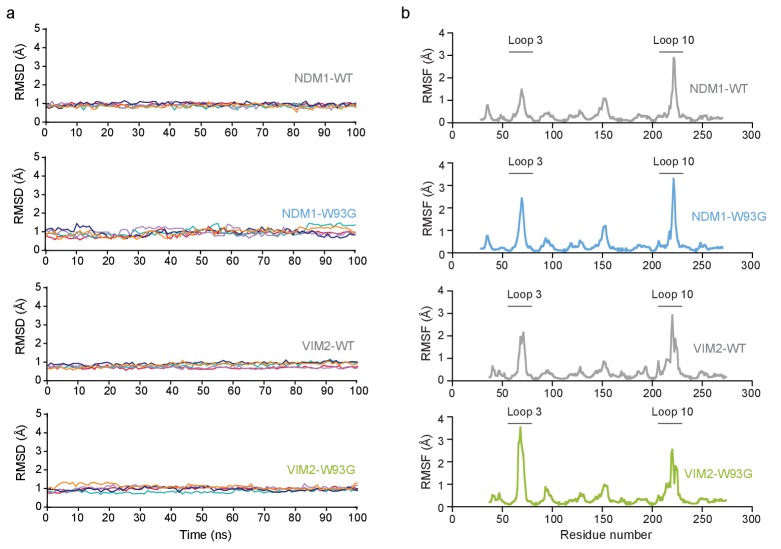
The molecular dynamics (MD) simulations of NDM1-WT, NDM1-W93G, VIM2-WT, and VIM2-W93G.(A) Root-mean square deviations (RMSD, Å) of all the C-α atoms from the MD simulations of NDM1-WT, NDM1-W93, VIM2-W93G in complex with PPP. The relevant enzyme variants are indicated on each panel. The data is presented individually for five independent 100 ns trajectories in each system, and for clarity, the data was plotted using cspline smoothing function implemented in Gnuplot. (B) Root-mean square fluctuations (RMSF, Å) of C-α atoms during the MD simulations. The data was calculated from the last 50 ns of all five 100 ns simulations of each of the four enzyme-PPP complexes (specific variant indicated in each panel).